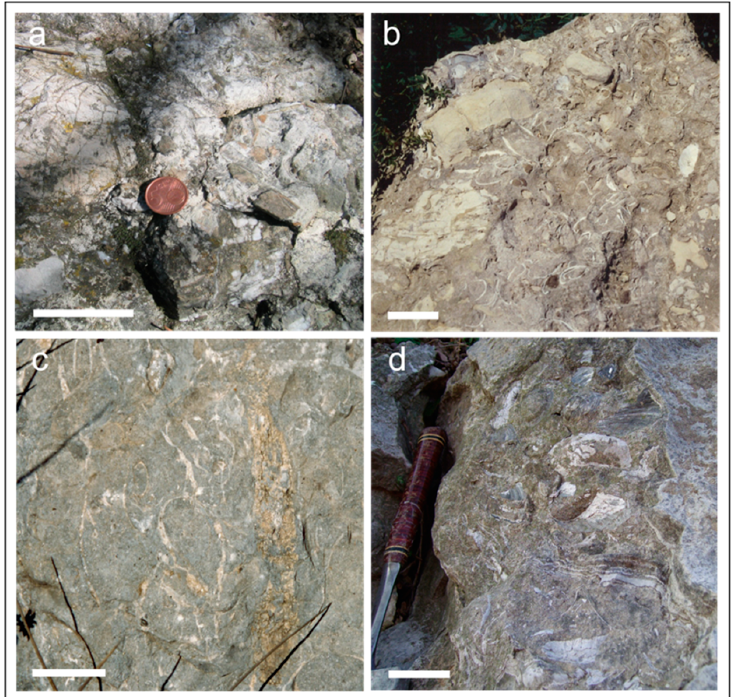
Figure 5. Recurrent seep-carbonate facies. ( a ) Polygenic breccias with clasts sourced from Ligurian units (Montebaranzone area, outcrop 1 in Figure 1). ( b ) Polygenic breccias with disarticulated bi- valves; clasts sourced from previously formed seep-carbonates and from the underlying Marnoso- arenacea Fm (Colline, outcrop 23 in Figure 1). ( c ) Complex network of veins and conduits (Deruta, outcrop 7 in Figure 1). ( d ) Layered structures associated with disarticulated bivalves and mottled micrite (Montepetra, outcrop 13 in Figure 1). Bar length = 5 cm.